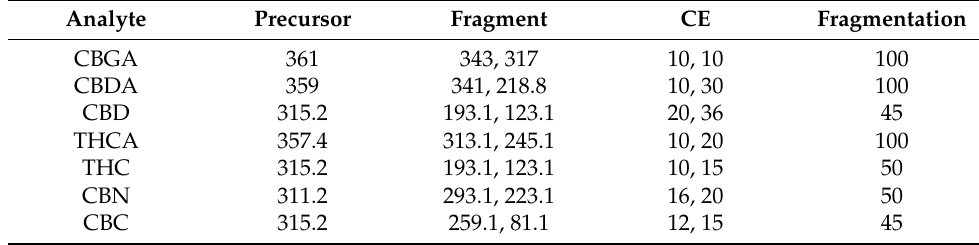
Table 1. MRM parameters of the LC-MS/MS